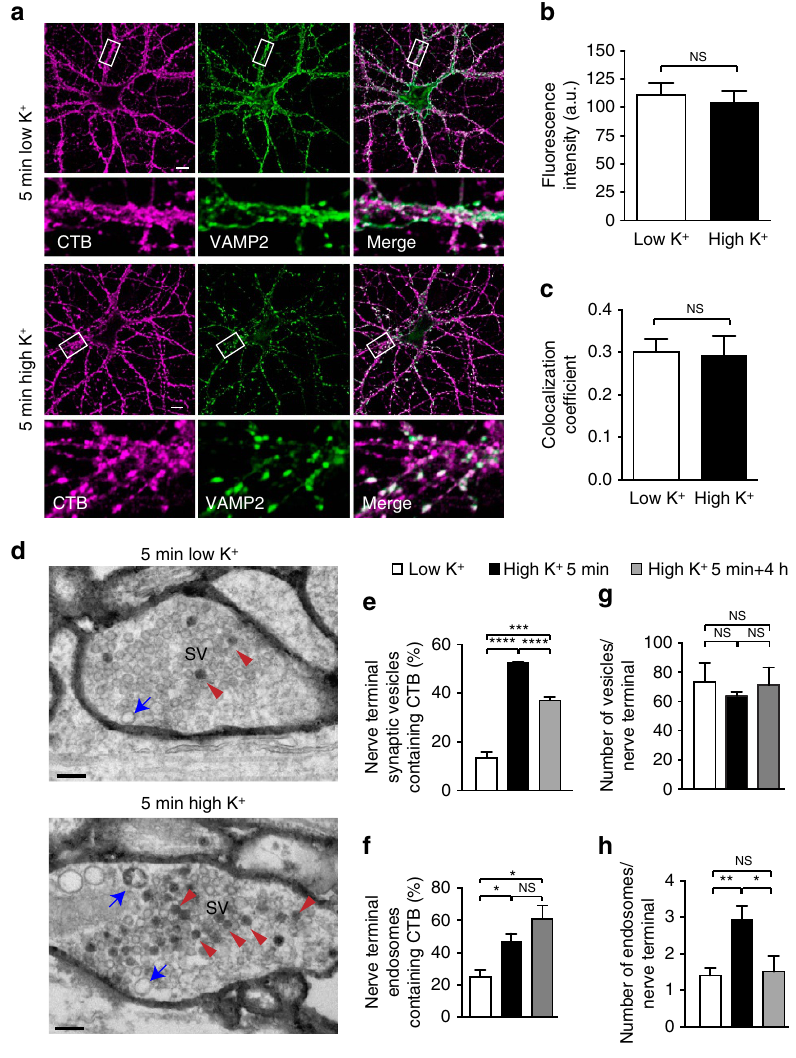
Figure 1 | Analysis of CTB binding and endocytosis in primary hippocampal neurons. ( a ) Cultured hippocampal neurons were washed once with low K þ buffer then incubated with CTB-Af555 for 5min in either low or high K þ buffer before fixation. Neurons were processed for immunocytochemistry using an anti-VAMP2 antibody. Scale abr, 10 m m. ( b , c ) Fluorescence intensity of CTB in regions of interest (ROIs) alone ( b ) or in co-localization with VAMP2 (Pearson’s coefficient) ( c ) were determined for each condition, and no significant difference in either analysis was observed between low and high K þ treatments. (mean ± s.e.m., n ¼ 3 independent experiments, 10 cells (2 ROIs each) per experiment, Student’s t -test). ( d ) Cultured hippocampal neurons incubated with CTB-HRP (10 m gml (cid:2) 1 ) for 5min in either low or high K þ buffer before fixation. Cells were fixed, processed for DAB cytochemistry and imaged by electron microscopy. Compartments within the presynaptic terminal containing endocytosed CTB were identified using the DAB reaction product. Compartments were identified as vesicles (red arrowheads) or endosomes (blue arrows). Scale bar, 200nm. ( e – h ) Cultured hippocampal neurons were treated as in a , then either fixed (5min) or returned to growth medium for 4h before fixation (5min þ 4h). Following processing, the number of small vesicles ( o 80nm diameter) and endosomes ( 4 80nm diameter) per nerve terminal were quantified and the proportion of these compartments containing CTB was determined (mean ± s.e.m., n ¼ 3–4 individual neuron preparations, 4 20 nerve terminals per preparation. * P o 0.05, ** P o 0.01, *** P o 0.001, **** P o 0.0001, NS, not significant, Student’s t